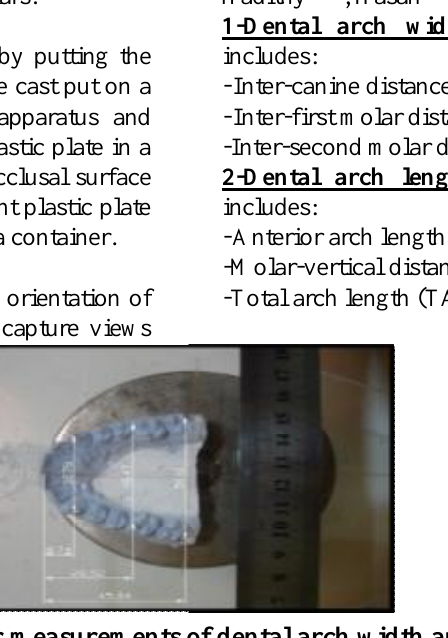
Figure 1: Linear measurements of dental arch width and